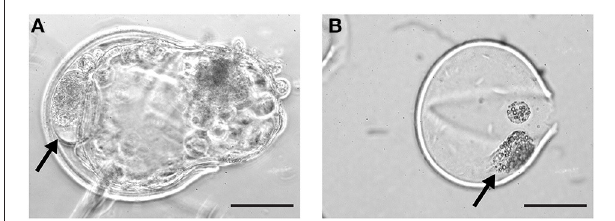
FIGURE 1 | Cellular fragments in day 9 bovine blastocysts. Fragmented cells (arrows) in the perivitelline space of a day 9 hatching blastocyst (A) and within the zona pellucida of a hatched blastocyst (B) . Scale bar = 50 µ m.